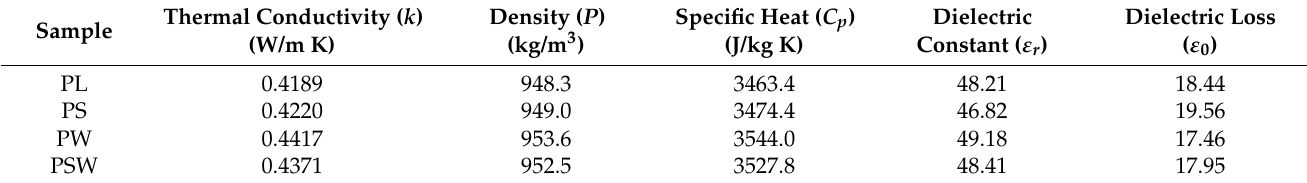
Table 2. Thermal and dielectric properties of the pork